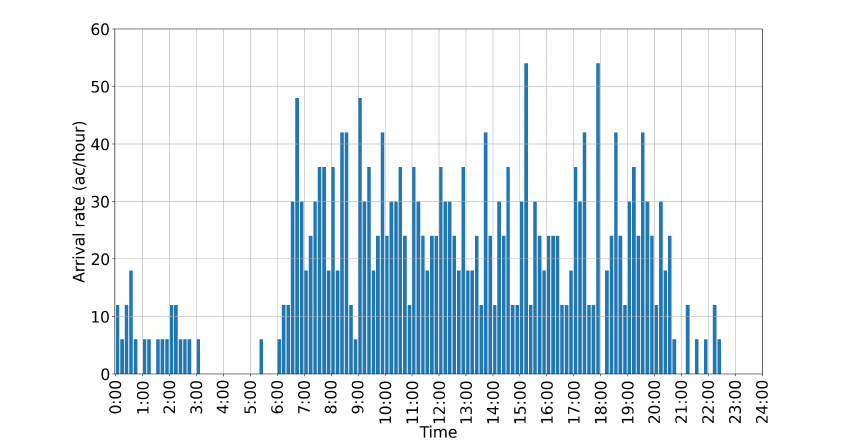
Figure 9. Arrival rate at the queuing